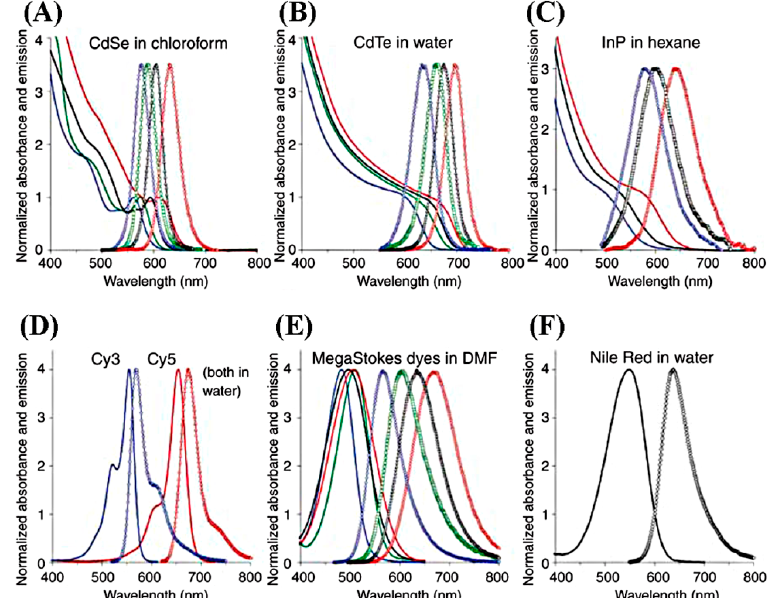
Figure 12. Comparison spectra of QDs and organic fluorescent dyes are displayed. Data shown as lines and symbols represent absorption and emission spectra, respectively. ( A – C ) QD spectra. Representative absorption and emission spectra are shown for the QDs of ( A ) CdSe, ( B ) CdTe, and ( C ) InP. ( D – F ) Organic dye spectra. Typical absorption and emission spectra for model organic dyes are displayed for ( D ) Cy3 and Cy5, ( E ) Megastokes and ( F ) Nile Red. Different colors in the spectra are coded by the size of the dye (blue < green < black < red). Reproduced with permission from Ref.